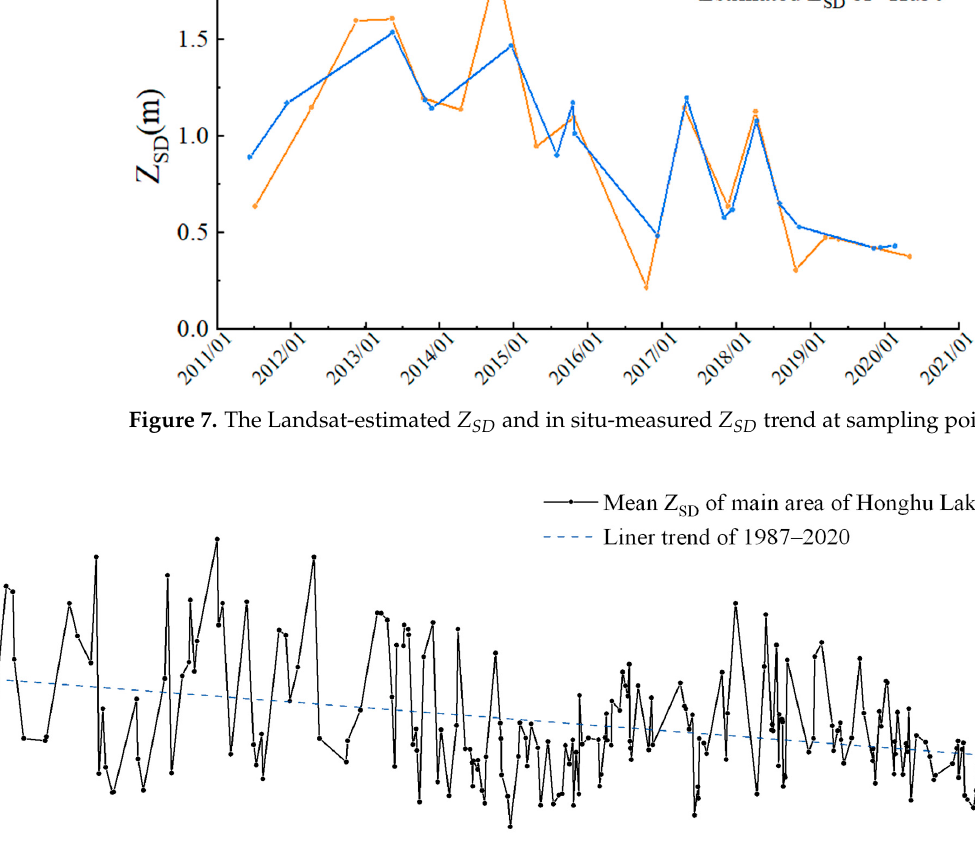
Figure 7. The Landsat-estimated Z SD and in situ-measured Z SD trend at sampling point Hu30.